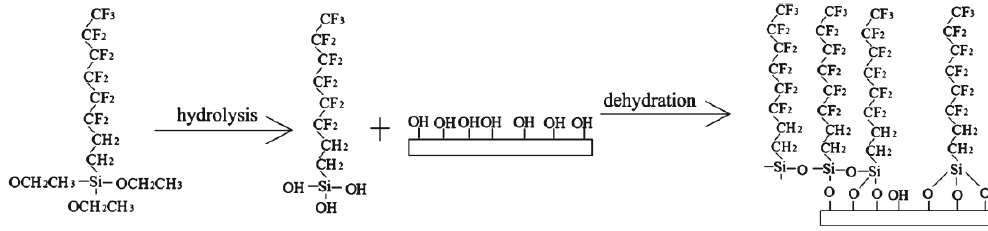
Figure 8. Formation mechanism of the self-assembled fluoroalkylsilane (FAS) film on the sheet surfaces.